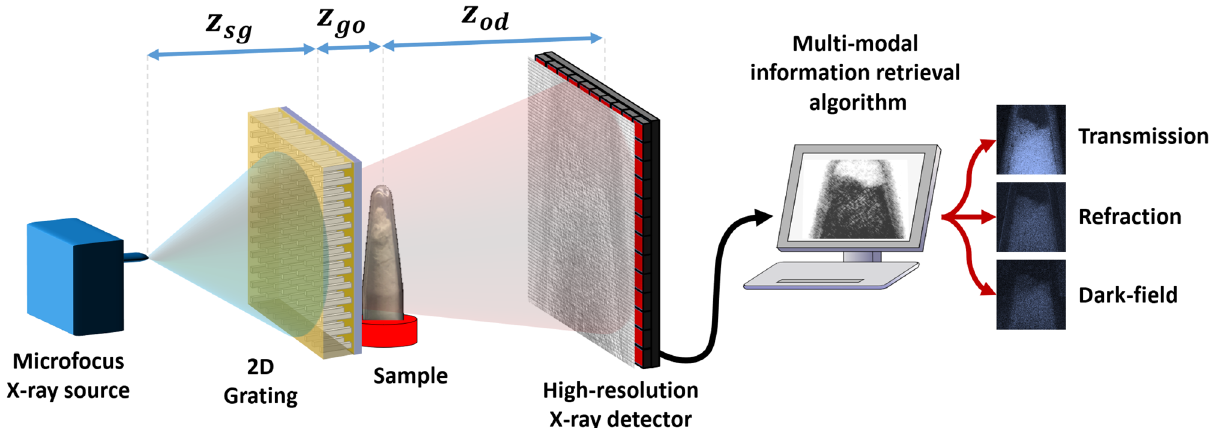
Figure 8. Schematic diagram of the X-ray setup used to perform X-ray phase-contrast imaging using a single X-ray absorption grating.